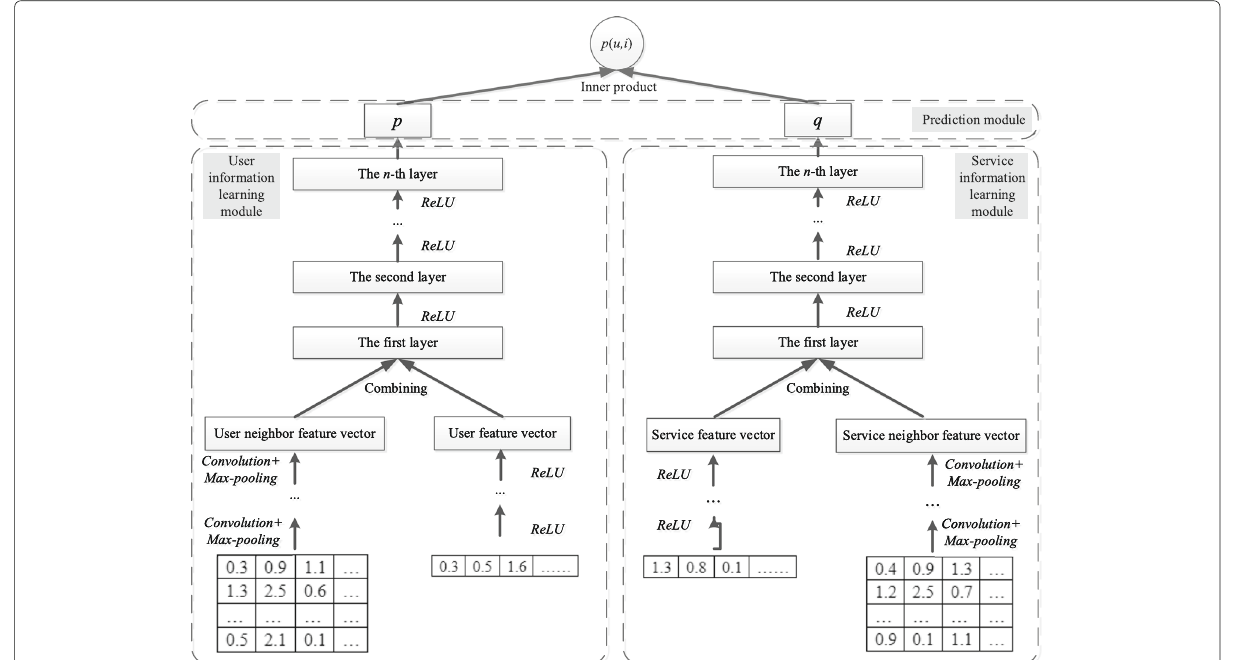
Fig. 1 Overall framework of NDL